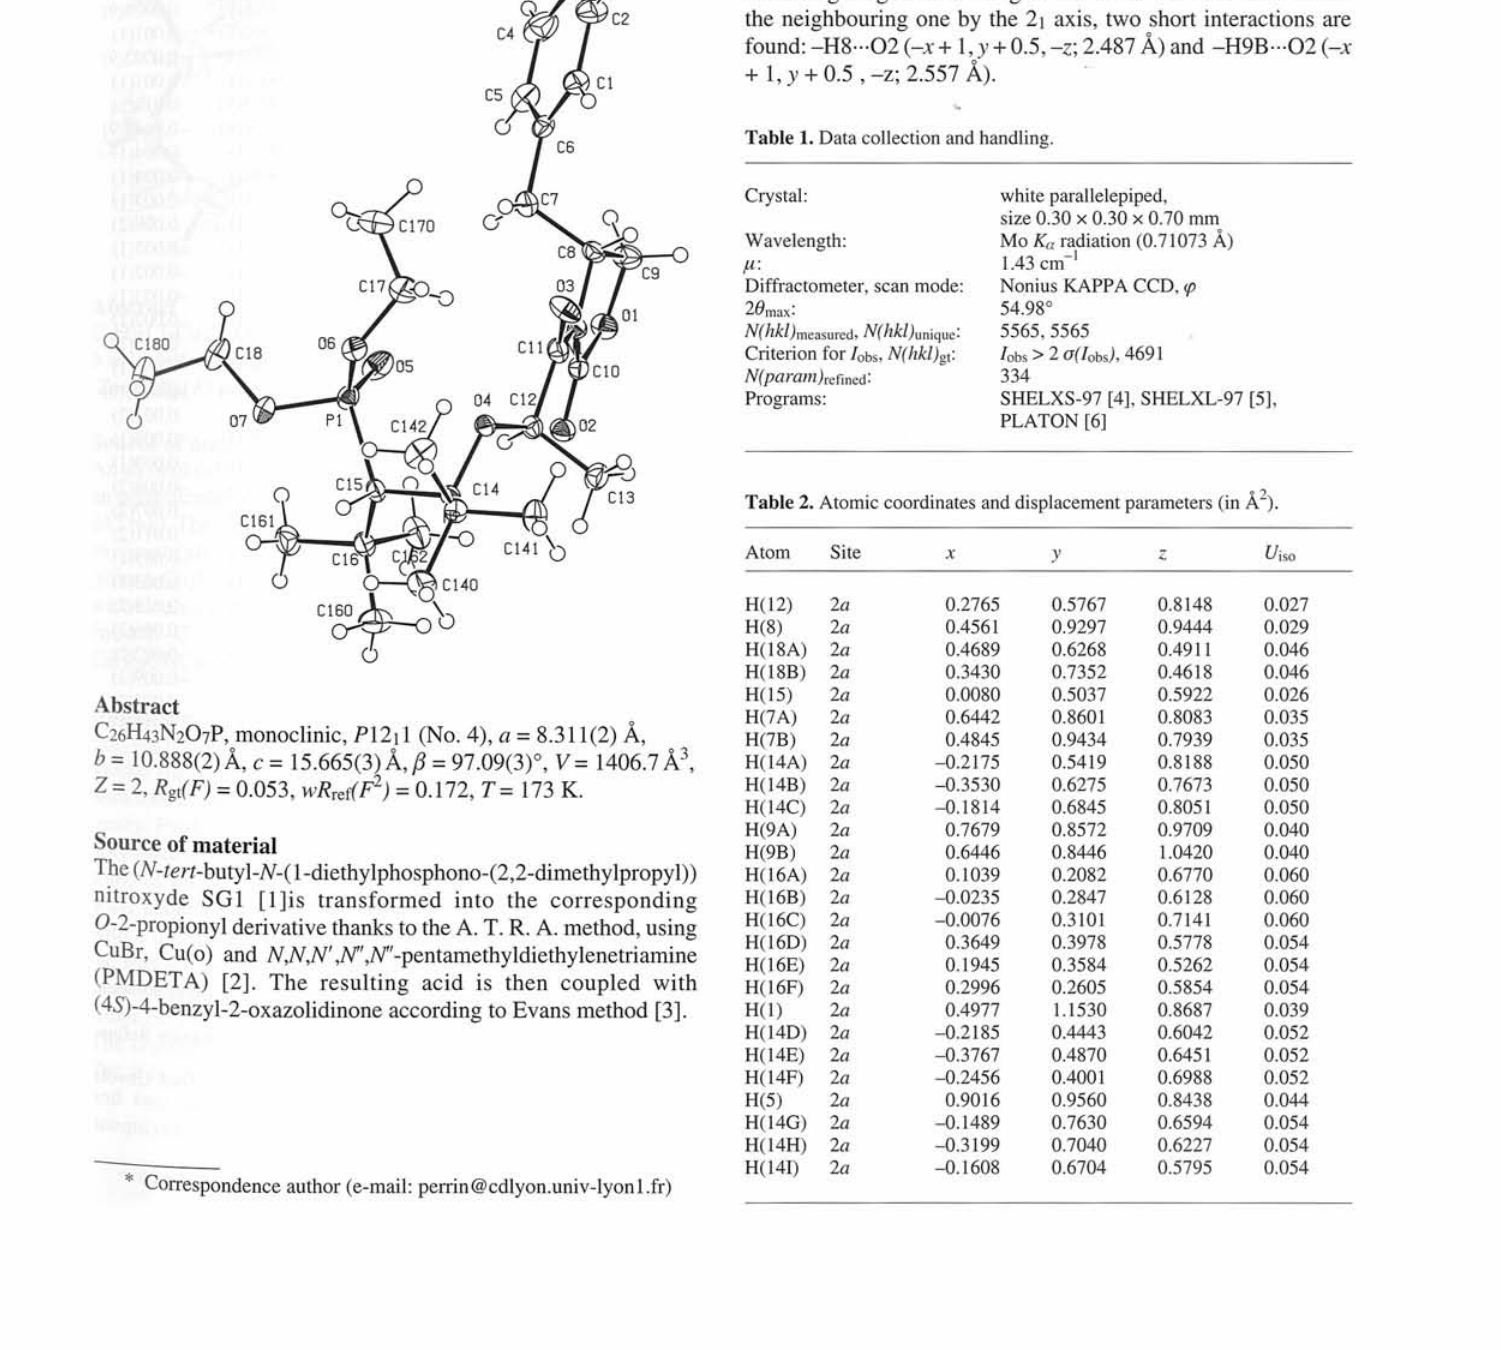
Table 1. Data collection and handling.